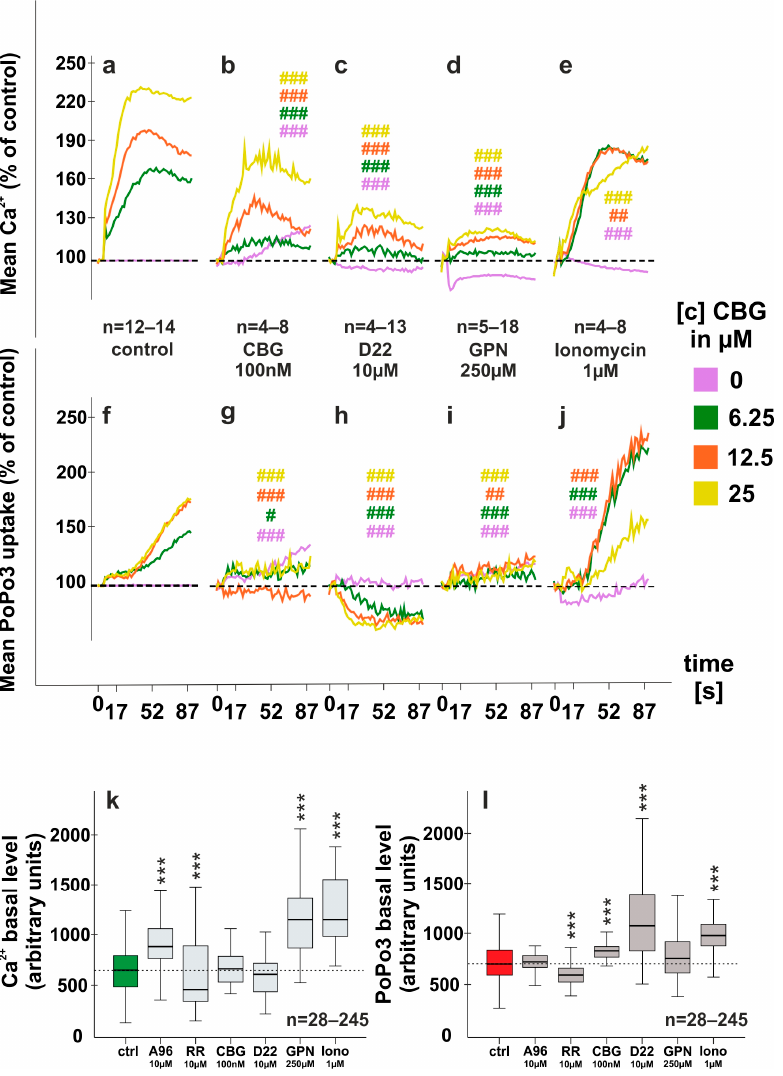
Figure 2. Modulation of CBG-induced calcium and PoPo3 uptake of RASF. ( a – j ) CBG-induced cal- cium ( a – e ) and PoPo3 uptake ( f – j ) are modulated by 30 min pre-incubation with either CBG (100 nM) ( b , g ), the organic cation transport inhibitor decynium-22 (D22) ( c , h ), the endoplasmic calcium re- leaser glycyl-l-phenylalanine 2-naphthylamide (GPN) ( d , i ) or the calcium ionophore ionomycin ( e , j ). ( k , l ) Absolute calcium ( k ) and PoPo3 levels ( l ) after 30 min incubation with the compounds indicated. # p < 0.05, ## p < 0.01, ### p < 0.001 for comparisons of CBG versus CBG/antagonist treatment at each concentration. ANOVA with Bonferroni post hoc test was used for comparisons ( a – j ). *** p < 0.001, for comparisons between different 30 min pre-incubation conditions before the addition of CBG. Kruskal-Wallis with Bonferroni post hoc test was used for comparisons (k, l ). RR = ruthenium red; A96 = A967079. Number of patients included: ( a , f ) n = 27 and n = 39 (no CBG); ( b , g ) n = 4 and n = 8 (no CBG); ( c , h ) n = 4 and n = 13 (no CBG) ( d , i ) n = 5 and n = 18 (no CBG) ( e , j ) n = 4 and n = 8 (no CBG). Number of experimental replicates from patient samples (see number of patients in Figures 1d–f and 2a–j): ( k , l ) n = 245 (ctrl), n = 46 (A96), n = 100 (RR), n = 28 (CBG), n = 33 (D22), n = 43 (GPN), n = 28